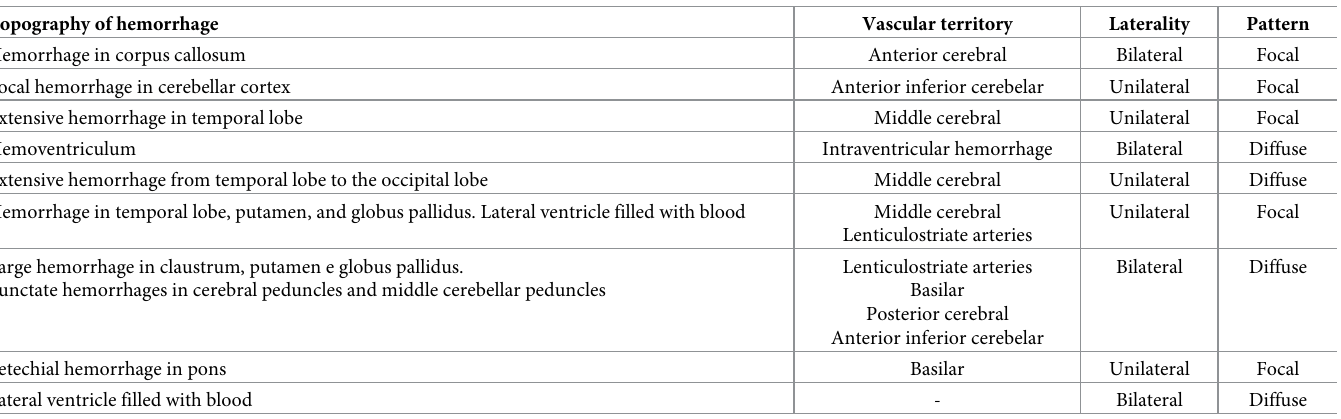
Table 4. Distribution of macroscopic hemorrhages and vascular